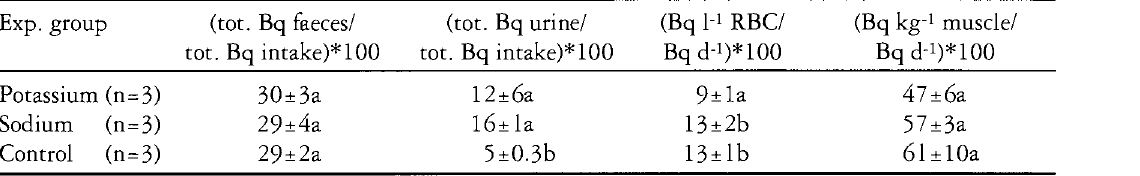
Table 6. Percent of total 134 Cs dose excreted via faeces and urine during the experimental period. Accumulated 134 Cs in RBC and muscle at the end of the experiment as % of daily dose for each